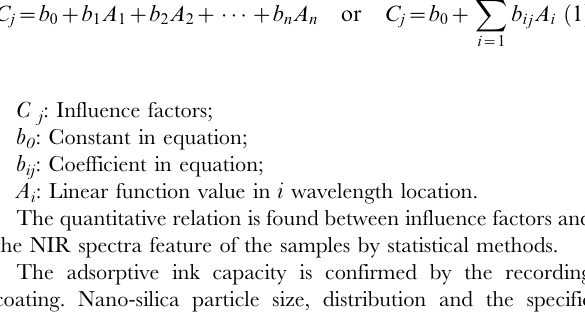
Table 1. Statistical results of the developing models.